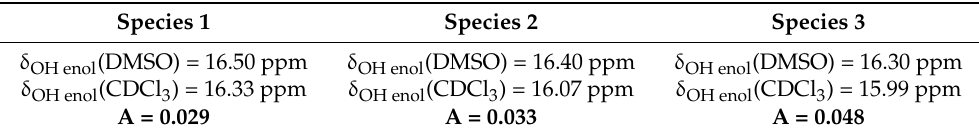
Table 10. Value of the A parameter estimated for 1 , 2 , and 3 using Abraham’s empirical formula. Species 1 Species